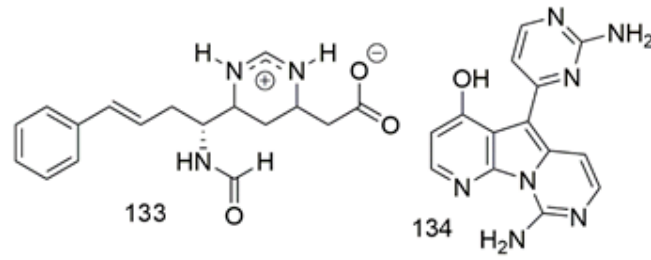
Figure 11. Pyrimidine alkaloid structure isolated from sponges. Table 11. Cytotoxic activity of pyrimidine alkaloids from sponges. Compound